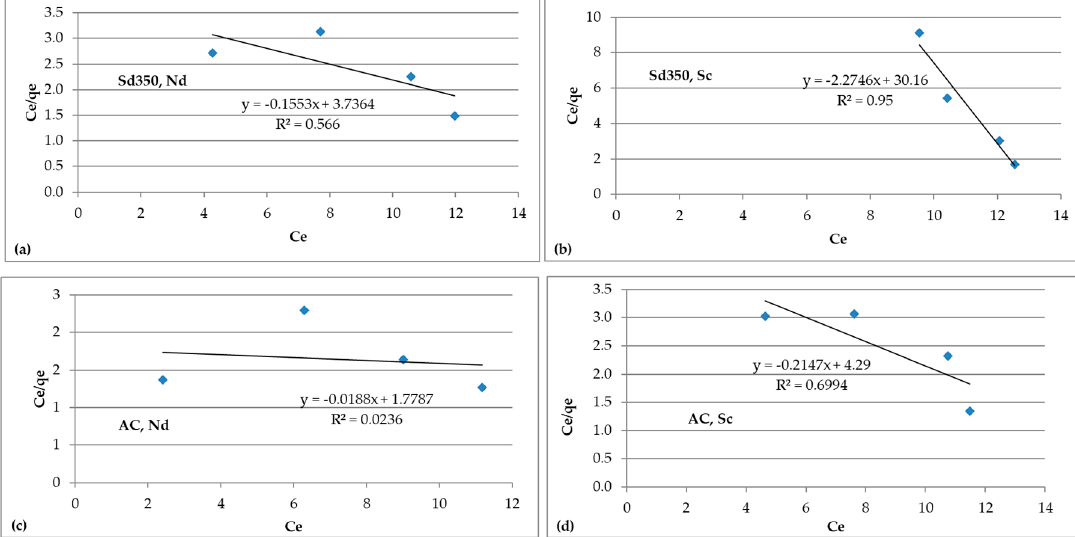
o G Δ (kJ mol − 1 ) values of adsorption of REEs on Sd350 and AC. Adsorbent − 3.23 − 0.23 AC − 4.92 − 2.96 3.4.3. Adsorption Mechanism The most important factors that define the adsorption efficiency of a carbon-rich material are the pore structure, the pore size distribution and the presence of surface functional groups [73]. The degree to which each factor contributes to adsorption depends on the characteristics of the initial raw material and the type of treatment applied, namely chemical or thermal, that defines the physico-chemical properties of the produced biochar or a commercial adsorbent. The increase of porosity and the development of micropores (0–2 nm) and mesopores (2–50 mn) that will increase the adsorption capacity of biochars can be accomplished through activation. Another issue that needs to be considered is potential blocking of pores as a result of mineralogical transformations occurring during pyrolysis or due to competition of ions present in solution [74–76]. Sd350 as deduced from the analyses carried out in the frame of the present study, mainly FTIR and SEM, is characterized by the presence of various active groups, such as the carbonyl, and quite well distributed adsorption sites, which enable adsorption of several metal and other ions present in aqueous solutions. Adsorption may be implemented through the involvement of several mechanisms, namely electrostatic interaction, chelation and complexation. In the present study, the results of speciation analysis indicate that the main species present in solution at pH 3 are Nd 3+ and NdSO 4+ for Nd and Sc 3+ , ScSO 4+ and some ScOH 2+ for Sc. It is thus believed that the main adsorption mechanism is cation exchange between –COOH and Sc or Nd as indicated in earlier studies [40,77]. Chemical adsorption and ion exchange were also proposed as potential mechanisms during the adsorption of light REEs (Y, La, Ce, Nd and Sm) on carbon black derived from recycled tires [36]. Furthermore, it is anticipated that electrostatic interactions may occur above the pH PZC between the previously mentioned positively-charged species of Nd and Sc and the carboxylic groups present